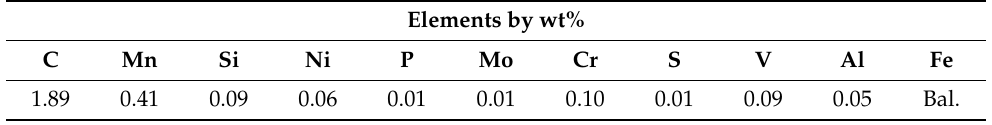
Table 1. Elemental compositions of galvanized steel